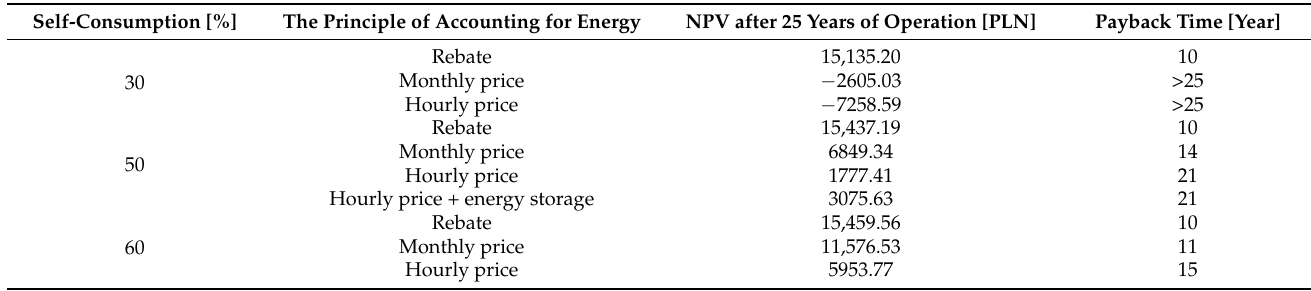
Table 9. Summary of NPVs for the PV installations